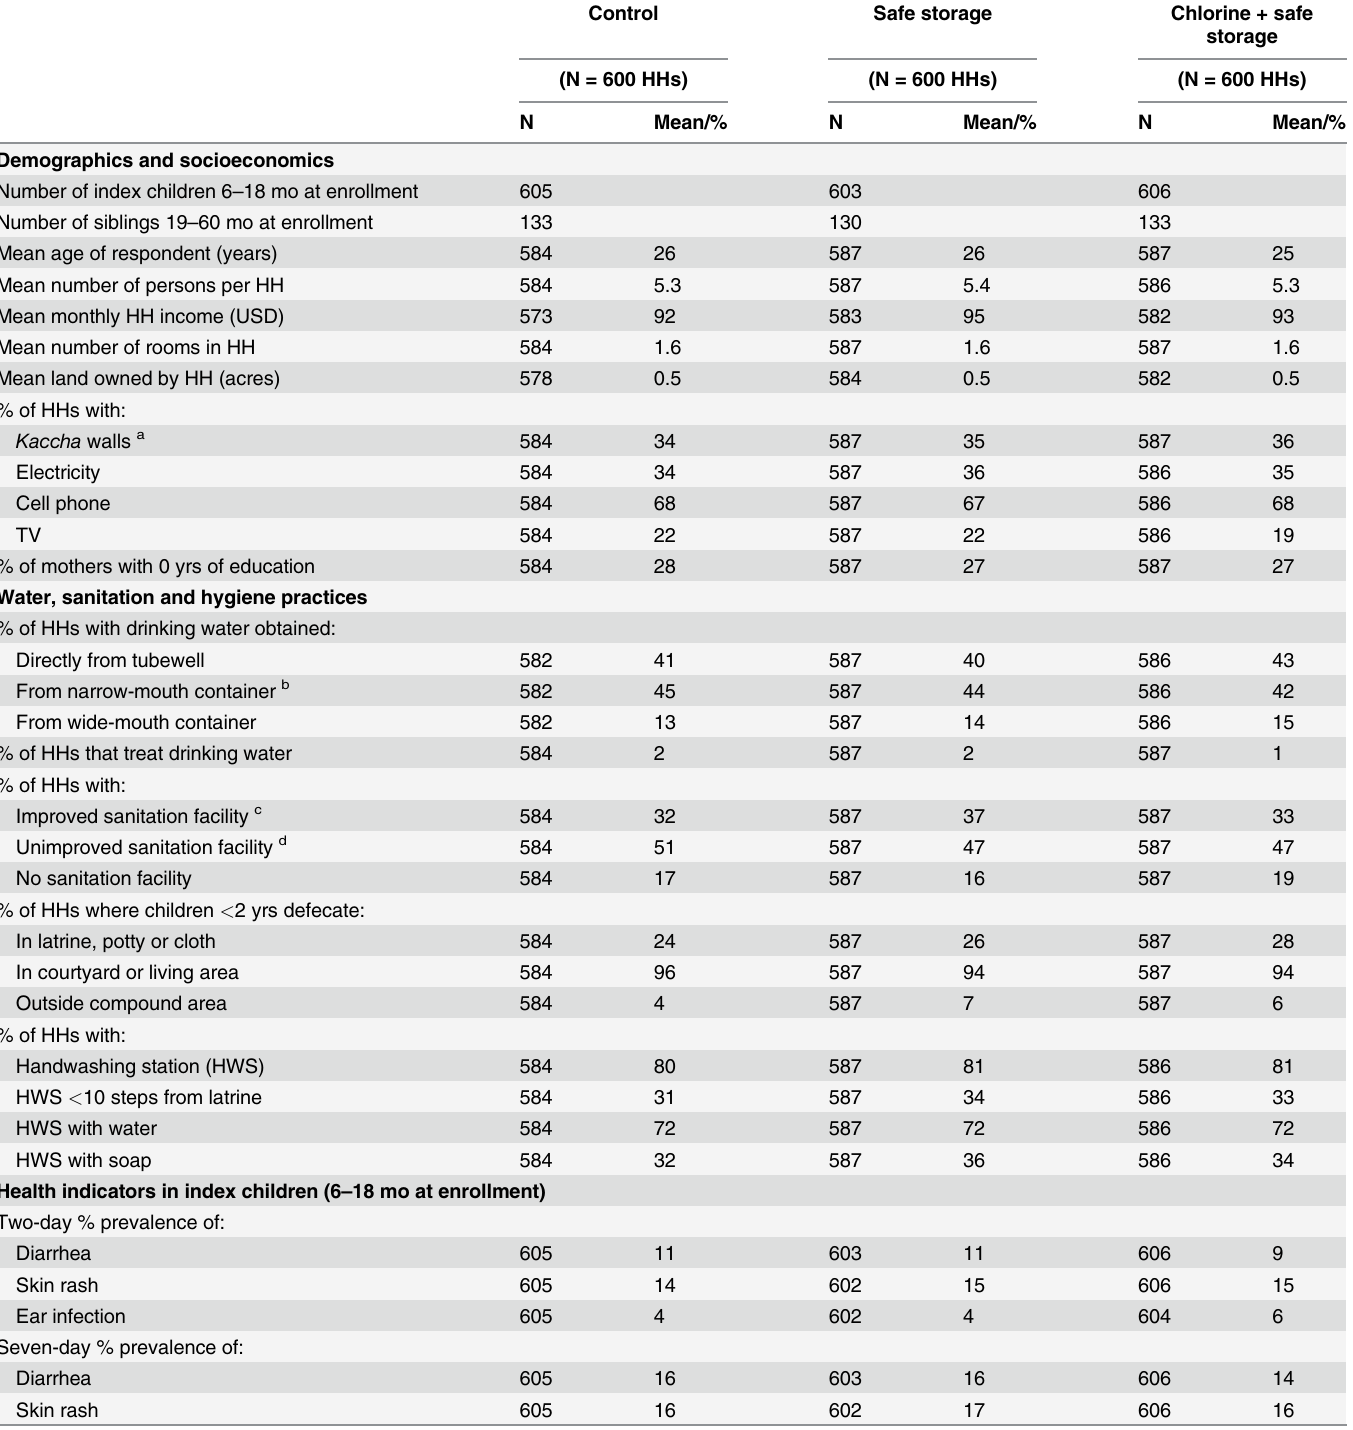
Table 1. Summary of baseline characteristics by study